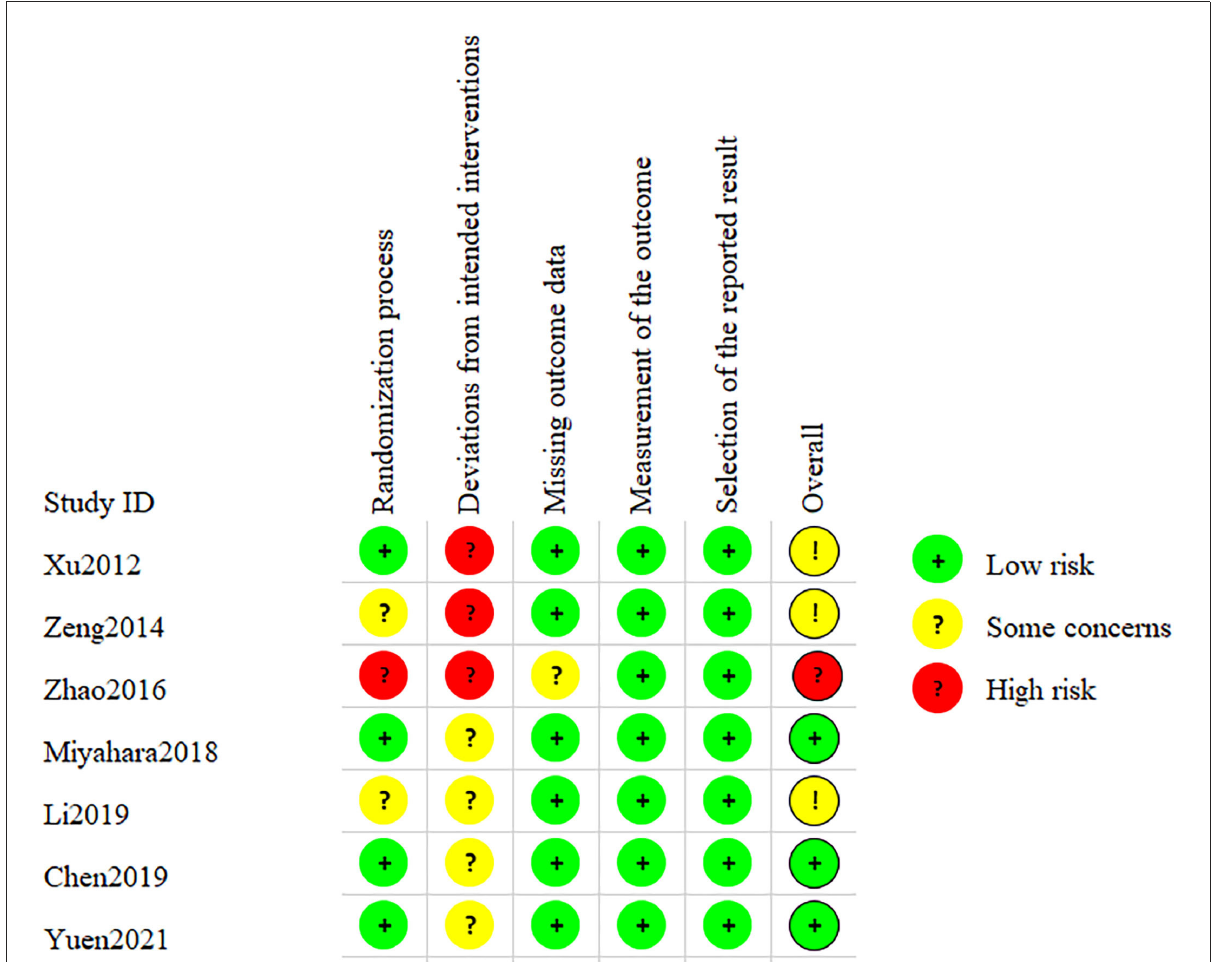
FIGURE3 Risk of bias of studies: review authors’ judgments of each risk of bias item for all included studies.